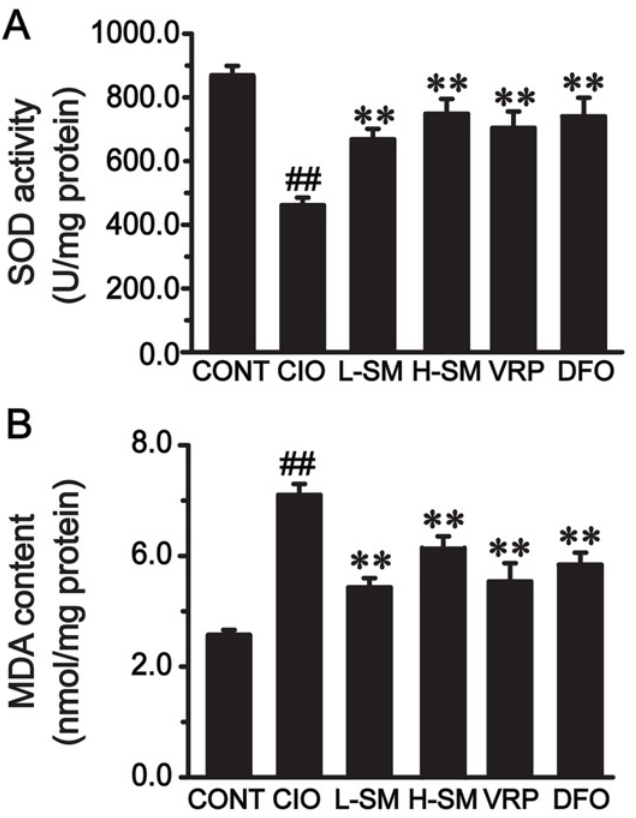
Fig 3. Effects of SM treatment on SOD activity and MDA content in heart homogenates. SOD activity (A) and MDA content (B) in each group are shown. Values are means ± SEM. ## P < 0.01 vs. CONT group; ** P < 0.01 vs. CIO